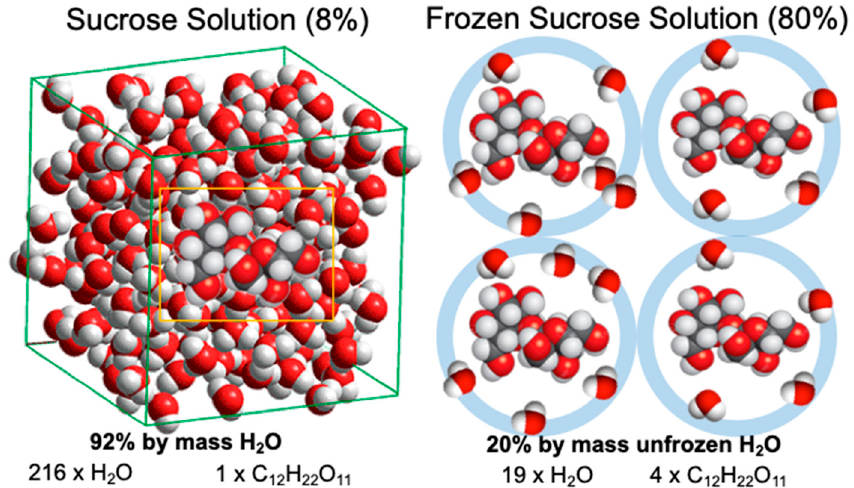
Figure 4. A schematic illustration of maximum freeze concentration in sucrose solutions. An 8% sucrose solution shows freeze concentration until 1 mol of sucrose molecules undergoes hydrogen bonding with approximately 4.75 mol water.